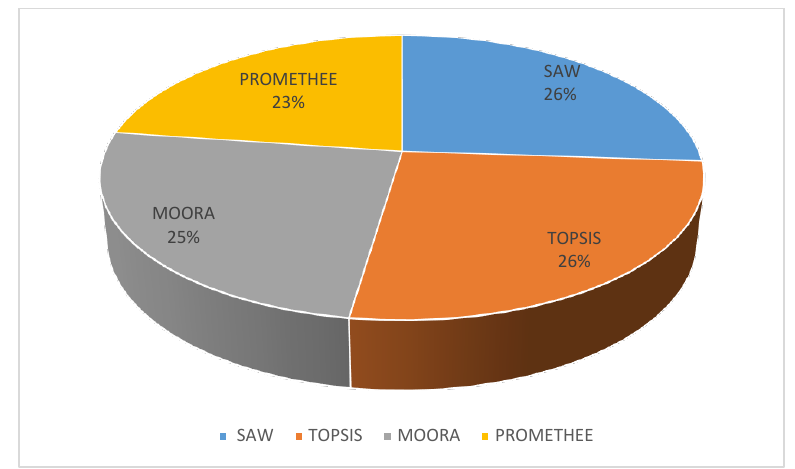
Figure 4. A comparison of stability determined by applying MADM methods.